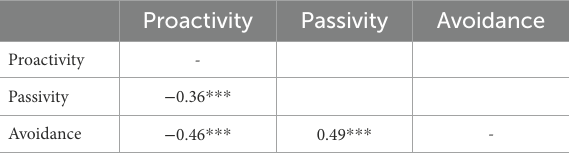
TABLE 4 Pearson bivariate correlation of PLAPMLS (25 items) of the exploratory factor sample ( n =